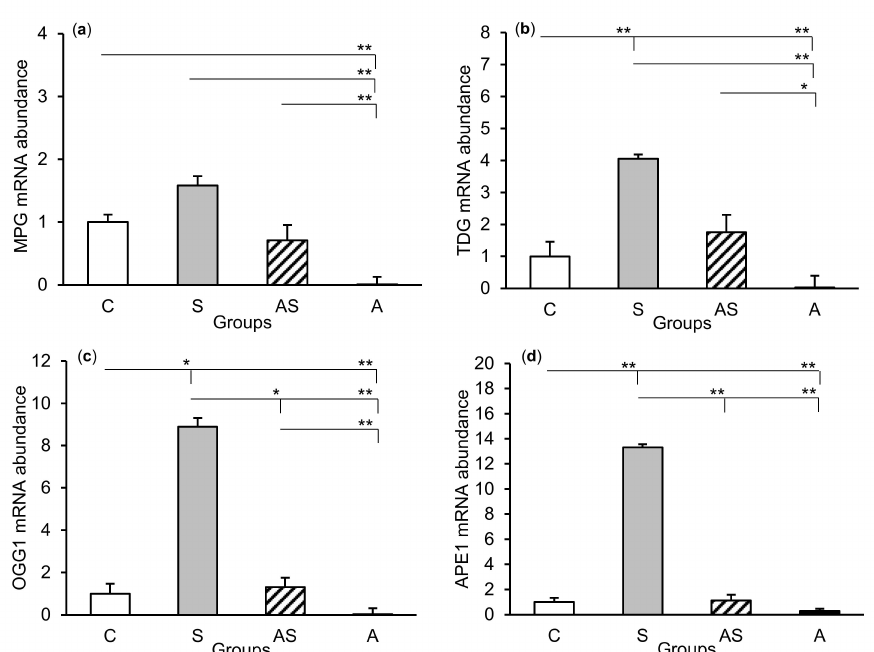
Figure 2. Relative mRNA abundance (mean ± SEM) of N-methylpurine-DNA glycosylase (MPG), ( a ) thymine-DNA glycosylase (TDG), ( b ) 8-oxoguanine glycosylase (OGG1), ( c ) and AP-endonuclease 1 (APE1), ( d ) in the hippocampal CA1 field of sheep treated with: vehicle (C), vehicle and stressful stimuli (S), allopregnanolone and stressful stimuli (AS), and allopregnanolone alone (A). Significance of di ff erences: * p < 0.05, ** p < 0.01.